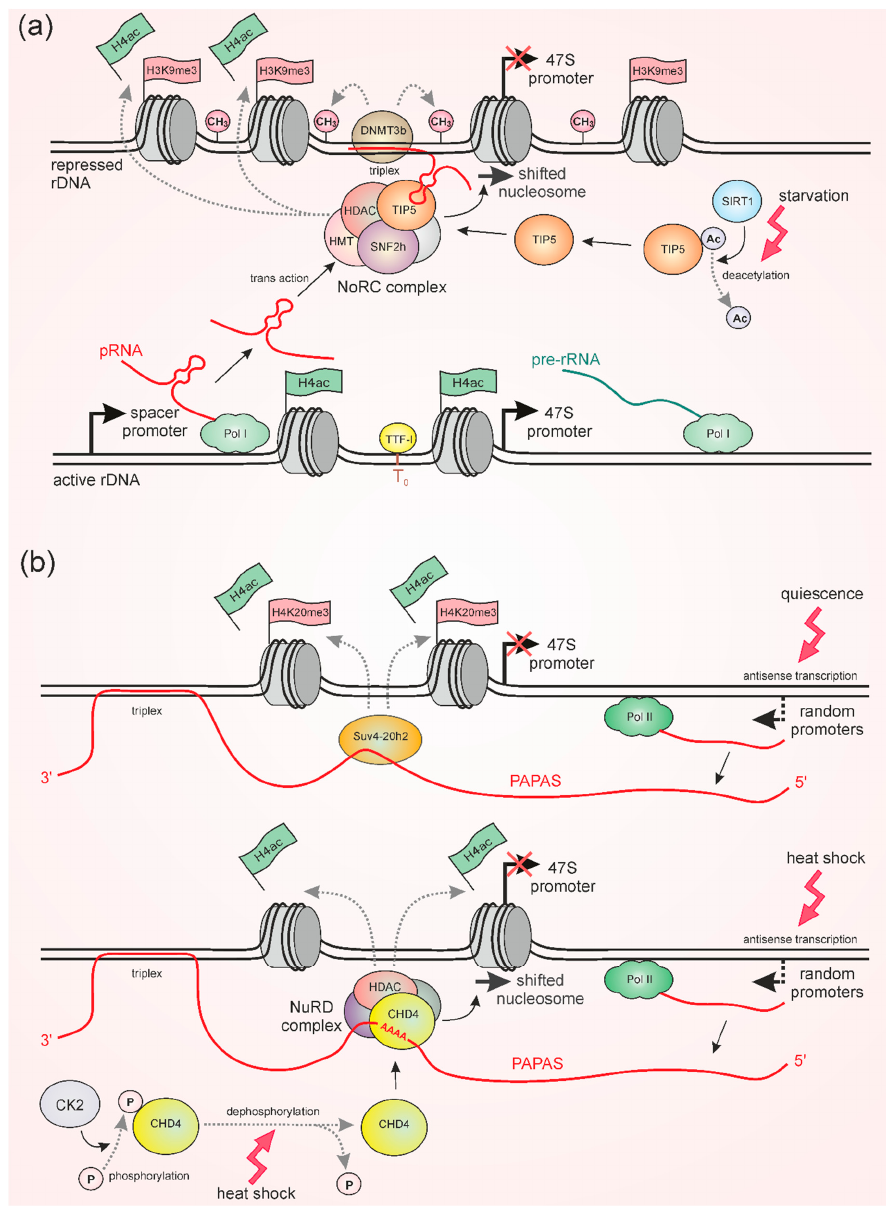
Figure 2. Mechanisms of pRNA and PAPAS action. ( a ) pRNA is transcribed by Pol I from spacer promoters juxtaposed to active rRNA genes. A hairpin structure of pRNA is recognized by TIP5 protein that allows it to form the Nucleolar Remodeling Complex (NoRC). Glucose starvation increases the activity of SIRT1, which deacetylates TIP5 and thereby enhances its association with pRNA. NoRC shifts a promoter nucleosome into a repressive position to block the 47S promoter and provides chromatin repression by histone deacetylation (removal of H4ac marks) and establishment of H3K9me3 modification. The 5 ′ -end of pRNA forms RNA-DNA triplex with T o site of the rDNA promoter. The triplex impairs TTF-I binding and recruits DNMT3b, which methylates DNA (indicated as CH3). ( b ) Quiescence and heat shock activate Pol II-mediated transcription of PAPAS antisense RNAs, which starts from random sites within the rDNA locus. PAPAS is able to anchor by forming DNA:RNA triplex with the enhancer element region in the IGS. Upon quiescence, PAPAS recruits Suv4-20h2, which establishes the repressive H4K20me3 mark at the rDNA. Under heat shock, PAPAS interacts with dephosphorylated CHD4 protein, a component of the NuRD complex that represses rDNA transcription by histone deacetylation and promoter nucleosome